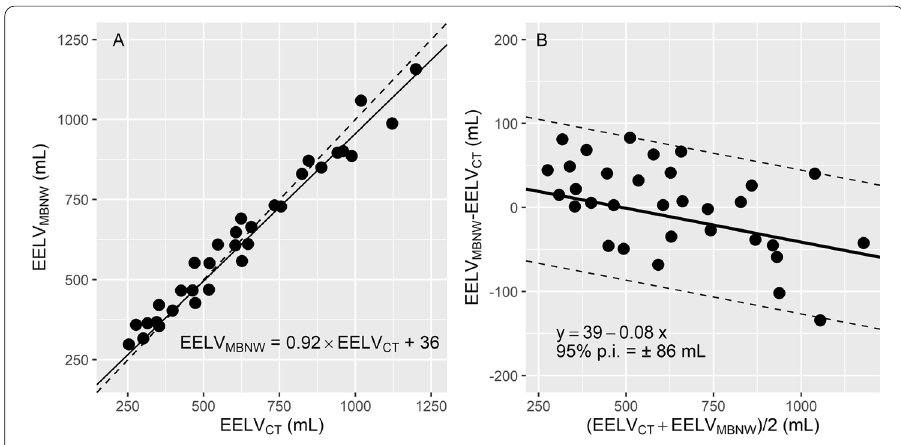
Fig. 2 Correlation between EELV MBNW and EELV CT ( A ) and corresponding Bland and Altman plot ( B ). Each symbol represents a concomitant measurement of end‑expiratory lung volume assessed with the multi‑breath nitrogen washin–washout technique (EELV MBNW ) and computed tomography (EELV CT ). A Solid line is regression line. Dashed line is line of identity. B continuous line and the 2 broken lines are the mean bias and 95% prediction interval limits of the bias between methods , respectively. 95% p.i. interval of the bias between methods